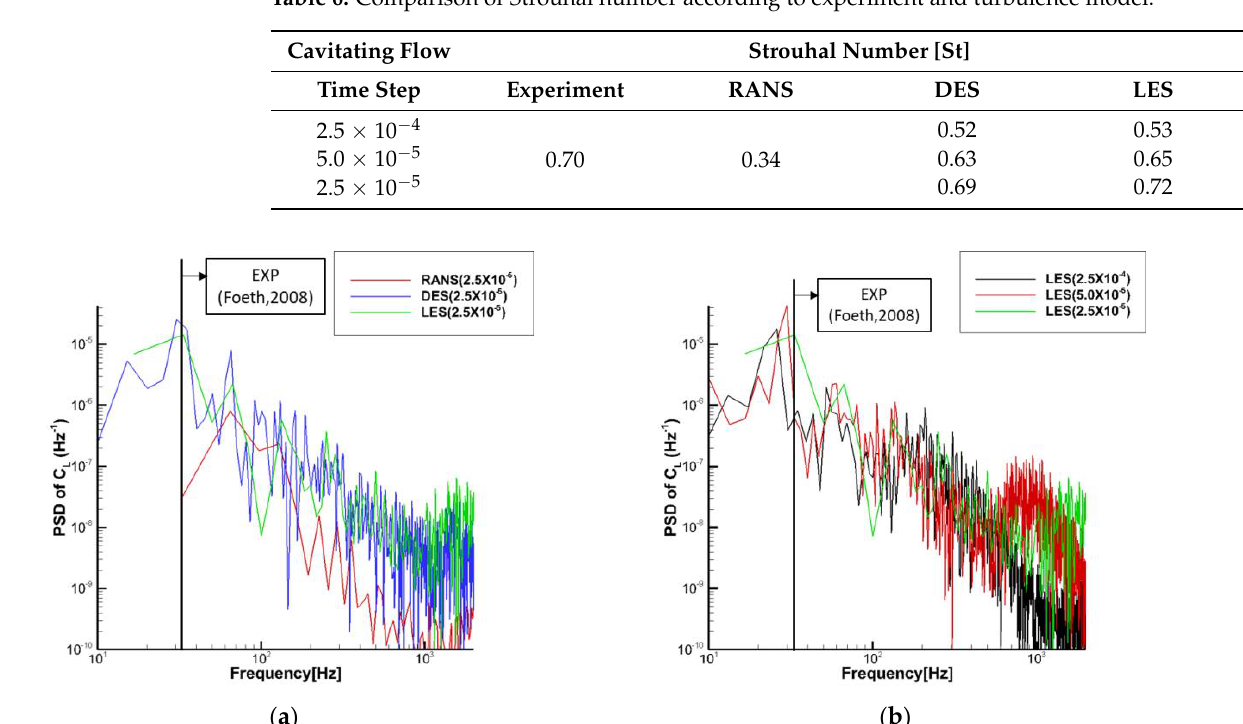
Figure 4. Power spectral density of lift coefficient (PSD of C L ) according to turbulence model ( a ) and time step ( b ).